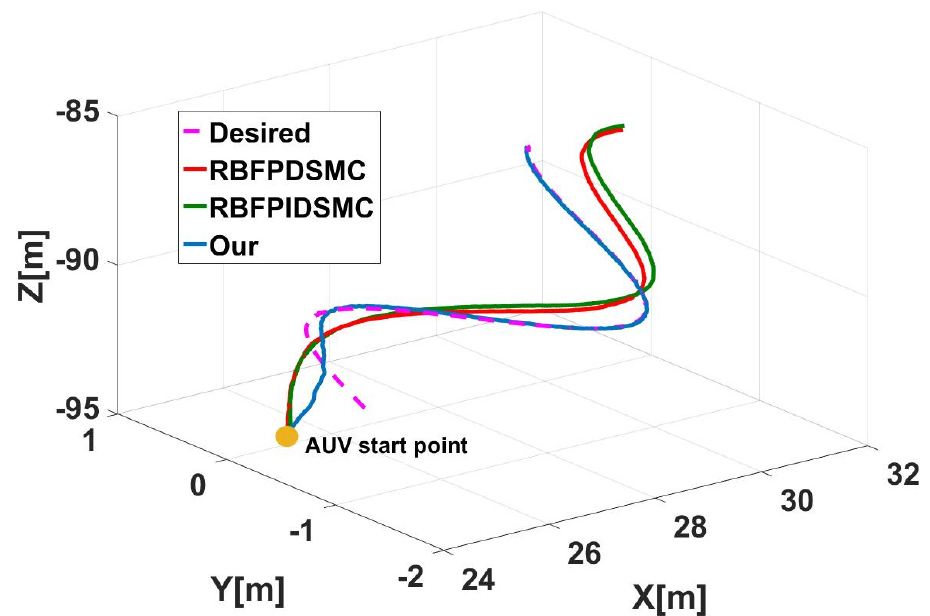
Figure 11. Three − dimensional view of the trajectory.